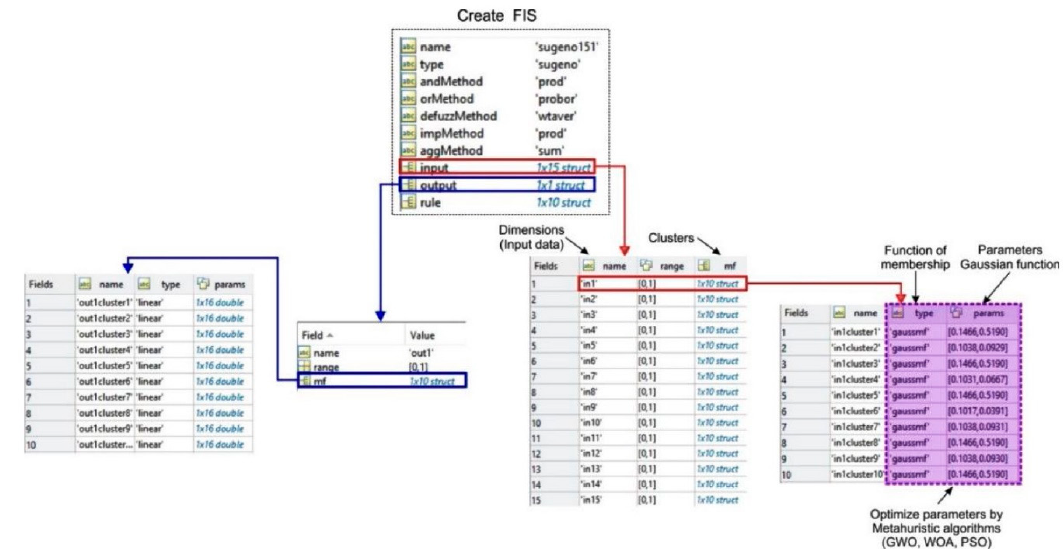
Figure 9. An example scheme of modelling producer of evolutionary optimization algorithms.